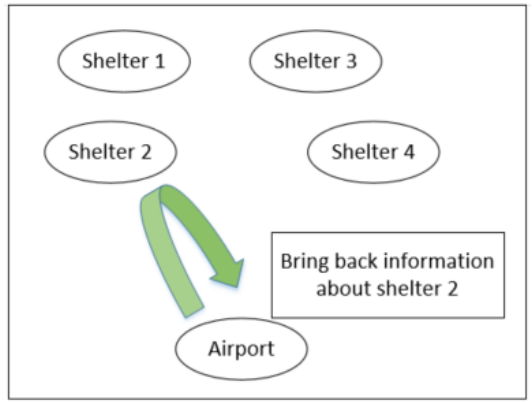
Figure 4. Information flow in Level one.